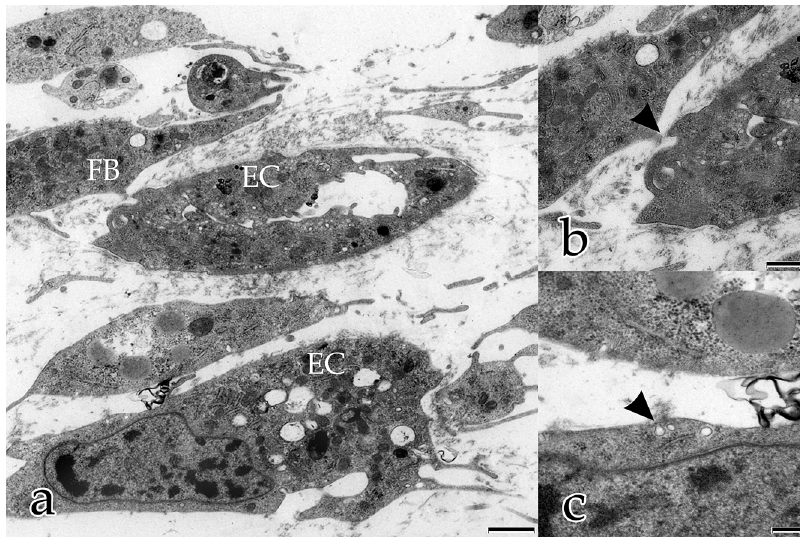
Figure 1. Coculture of ECs with FBs after 5 days: ( a – c ) intercellular communication between FBs, between ECs, and between FBs and ECs; ( b ), magnification of ( a ) EC and FB interaction by small protrusions (arrowhead); ( c ) magnification of ( a ) EC with small vesicles and caveolae extruding and/or ingesting extracellular material (arrowhead). ( a ) Bar: 1.000 nm, ( b ) Bar: 500 nm, ( c ) Bar: 250 nm.